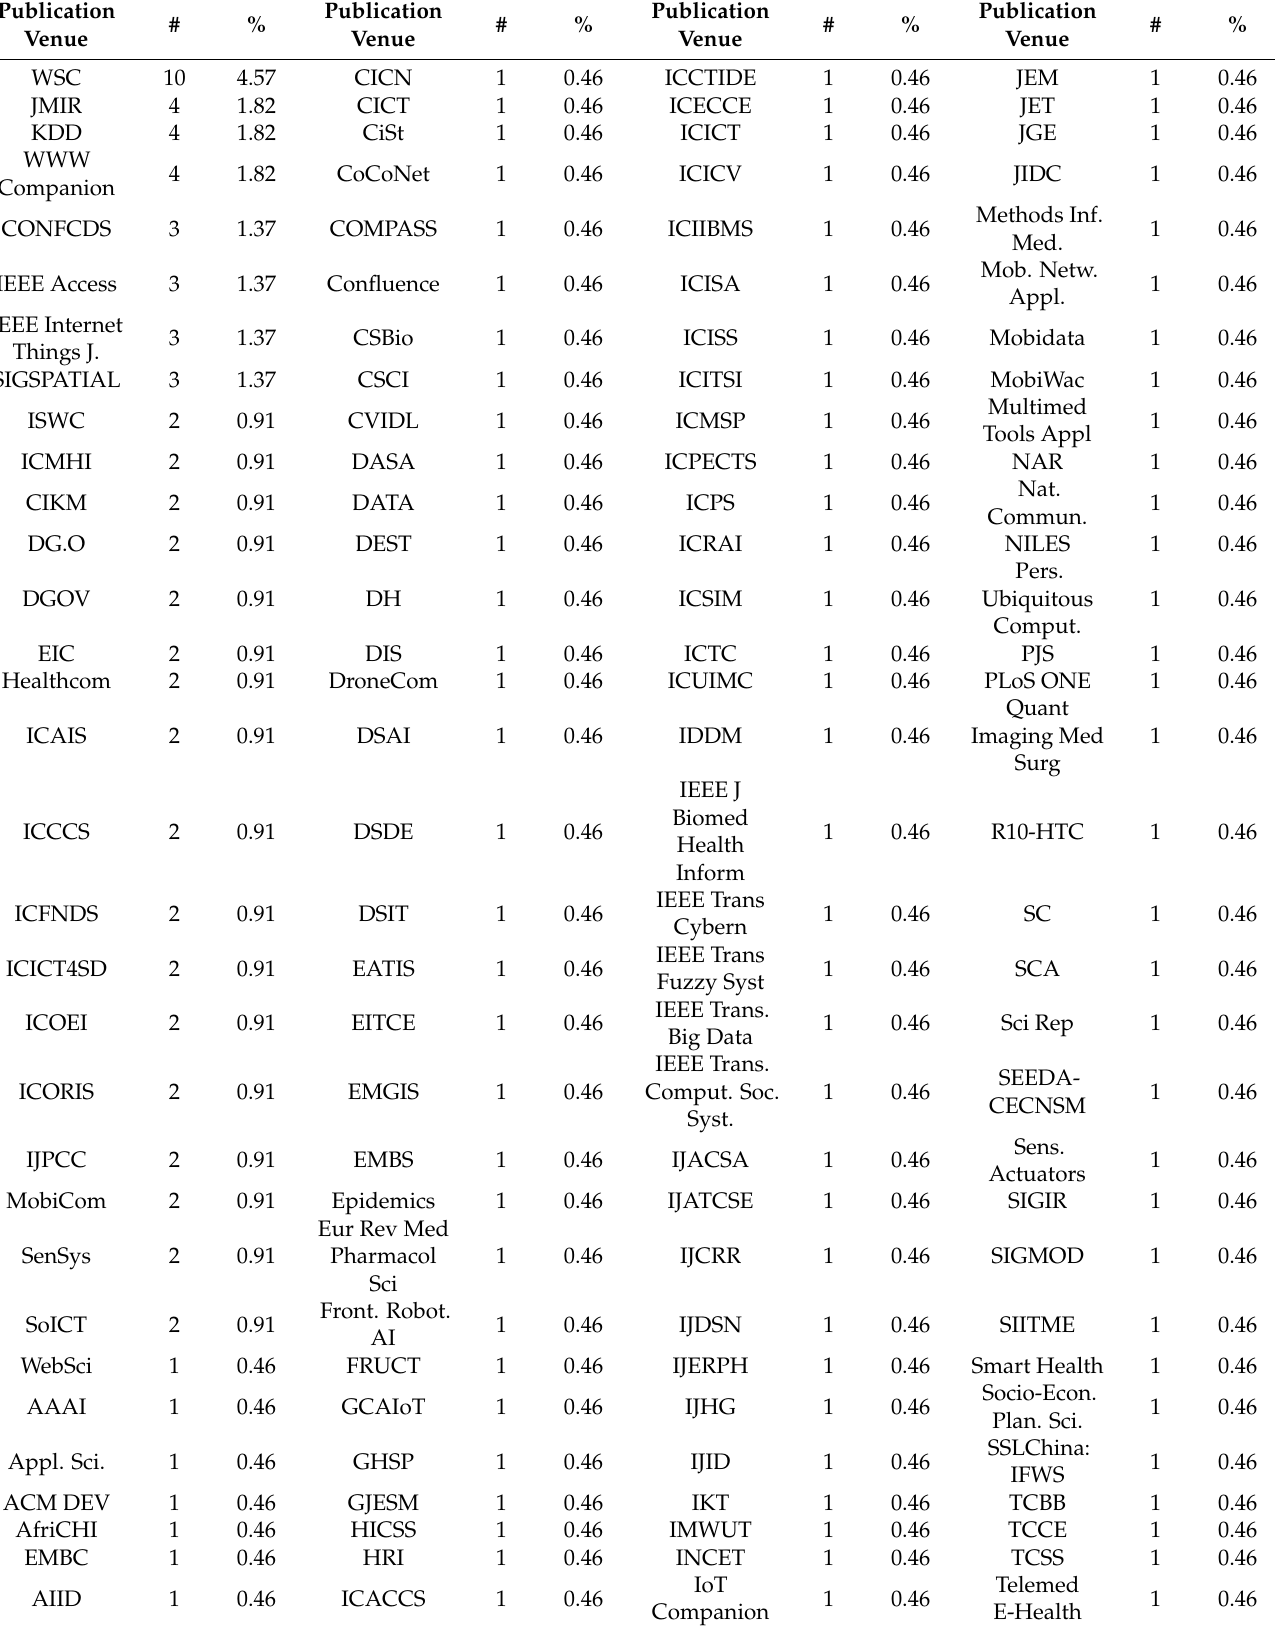
Table A3. Distribution of selected papers on publication